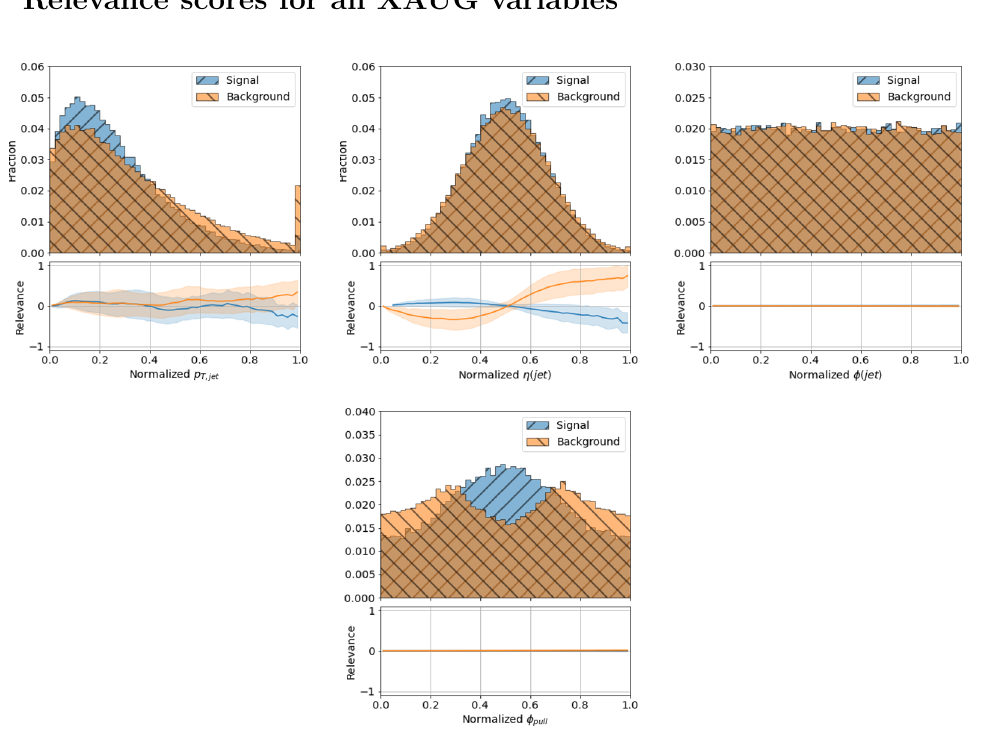
Figure 26. Histograms with profiles of normalized LRP relevances.